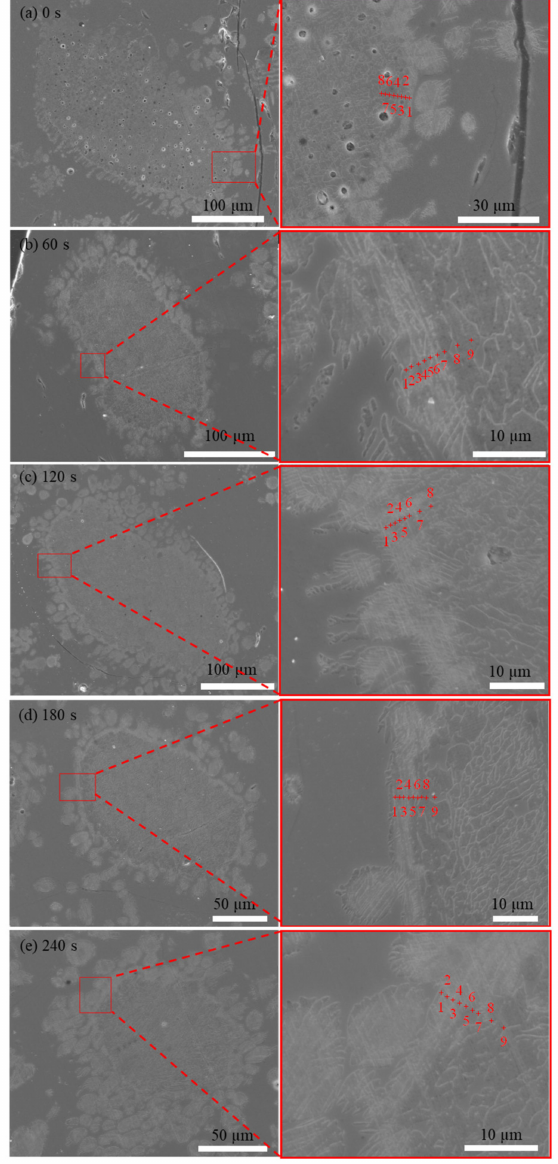
Figure 4. Diffusion morphologies of P 2 O 5 in the C 2 S particles with different times: ( a ) 0 s; ( b ) 60 s ( c ) 120 s; ( d ) 180 s; ( e ) 240